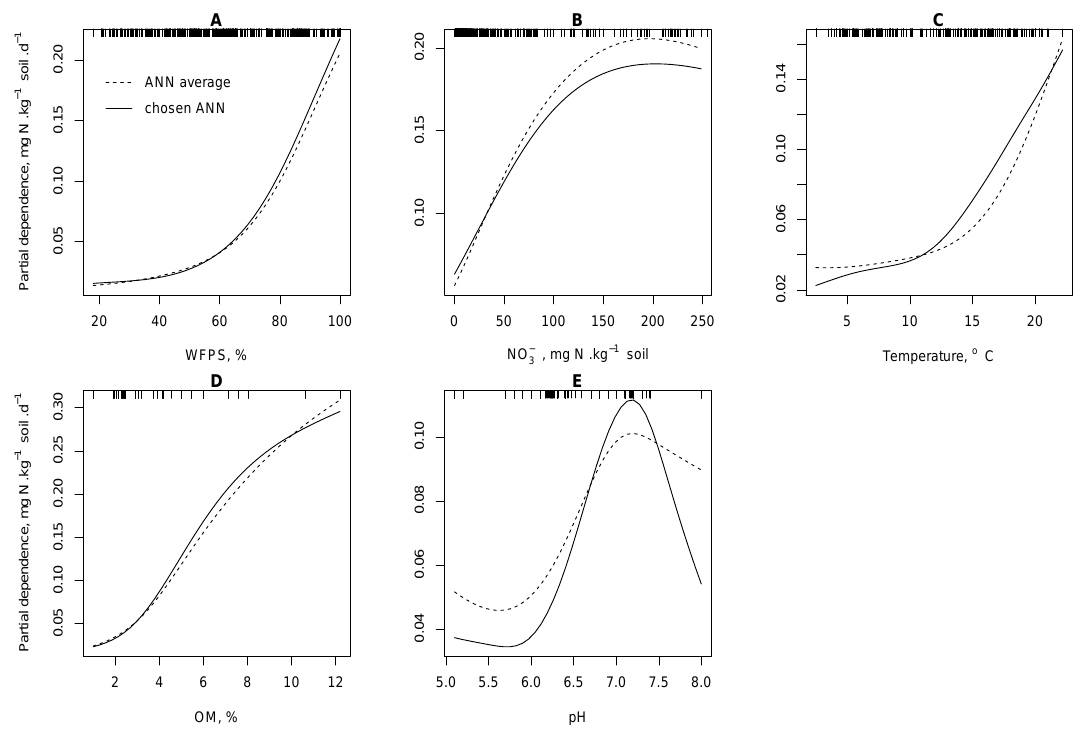
Fig. B2. Mean partial dependence of ANN5(OM,pH)G model and the partial dependence of the chosen ANN5(OM,pH)G. Rug plots on each subplot indicate the presence of the x-axis data in the dataset (e.g. only few different values of pH are present in the original dataset and so few lines appear in the rug plot of subplot E).